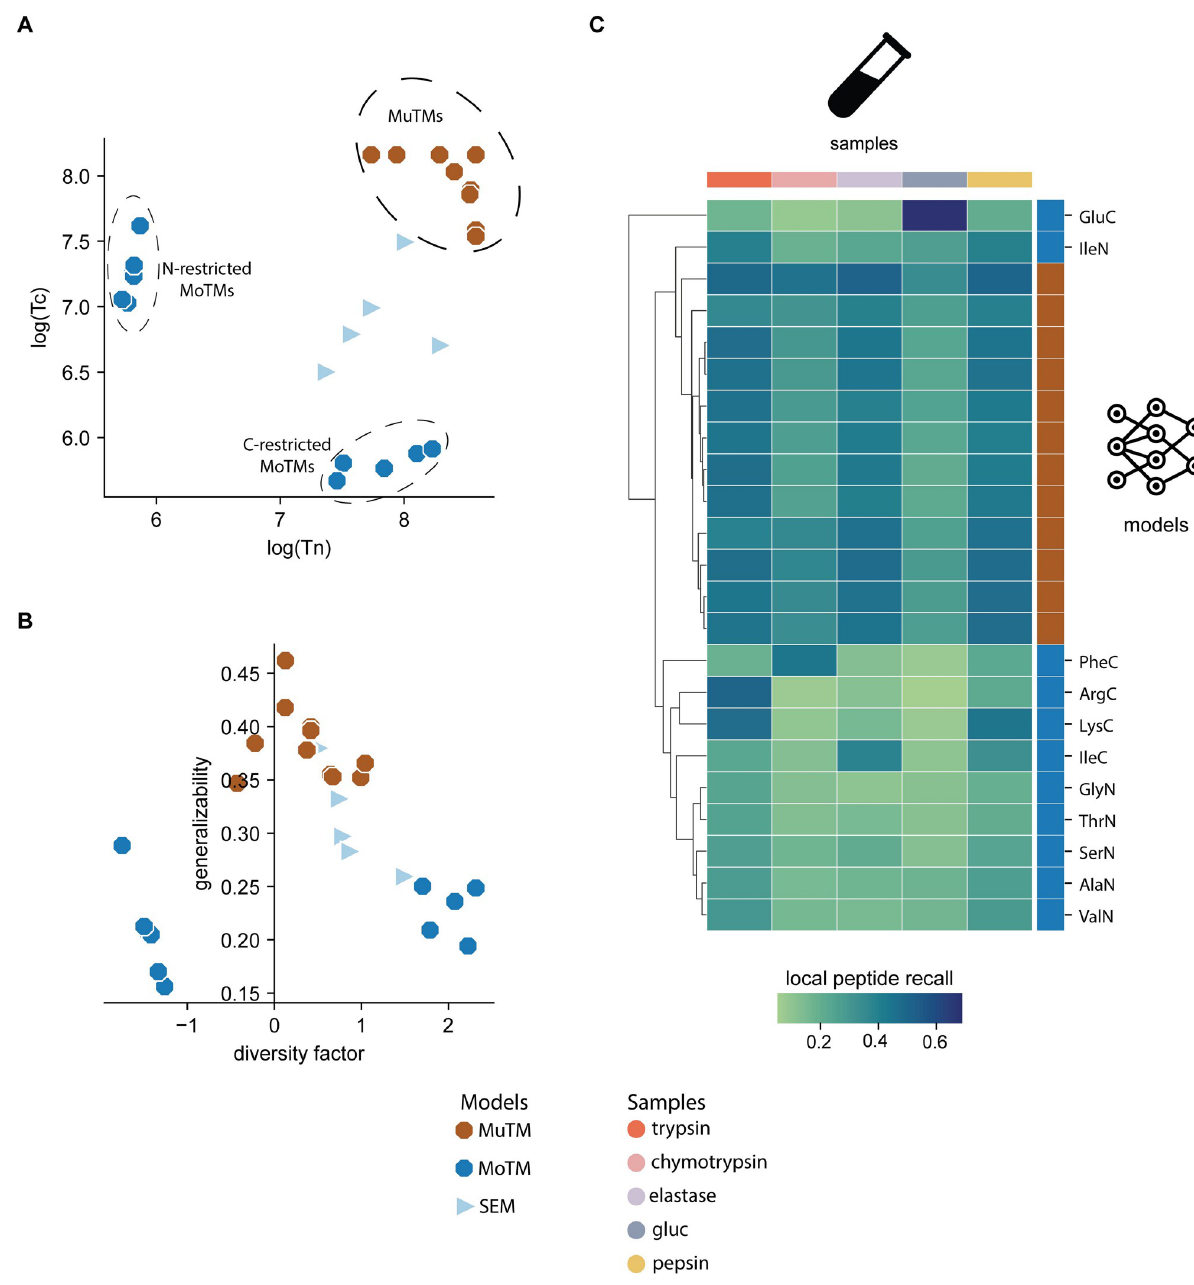
Fig 3. Modulating models’ generalizability by varying their training sets’ termini variability. Comparing Monoterminal (MoTM) and Multiterminal (MuTM) models’ characteristics and performances on the Detroit test set: A. Training sets N/C-termini variability for MoTMs and MuTMs; B. Models’ generalizability as a function of their termini diversity factor; C. MoTMs’ and MuTMs’ local peptide recall on Detroit test set components. We included SEMs’ Tn, Tc, and diversity factor parameters as a quantitative reference. Color and shape schemes for models and sample types are at the